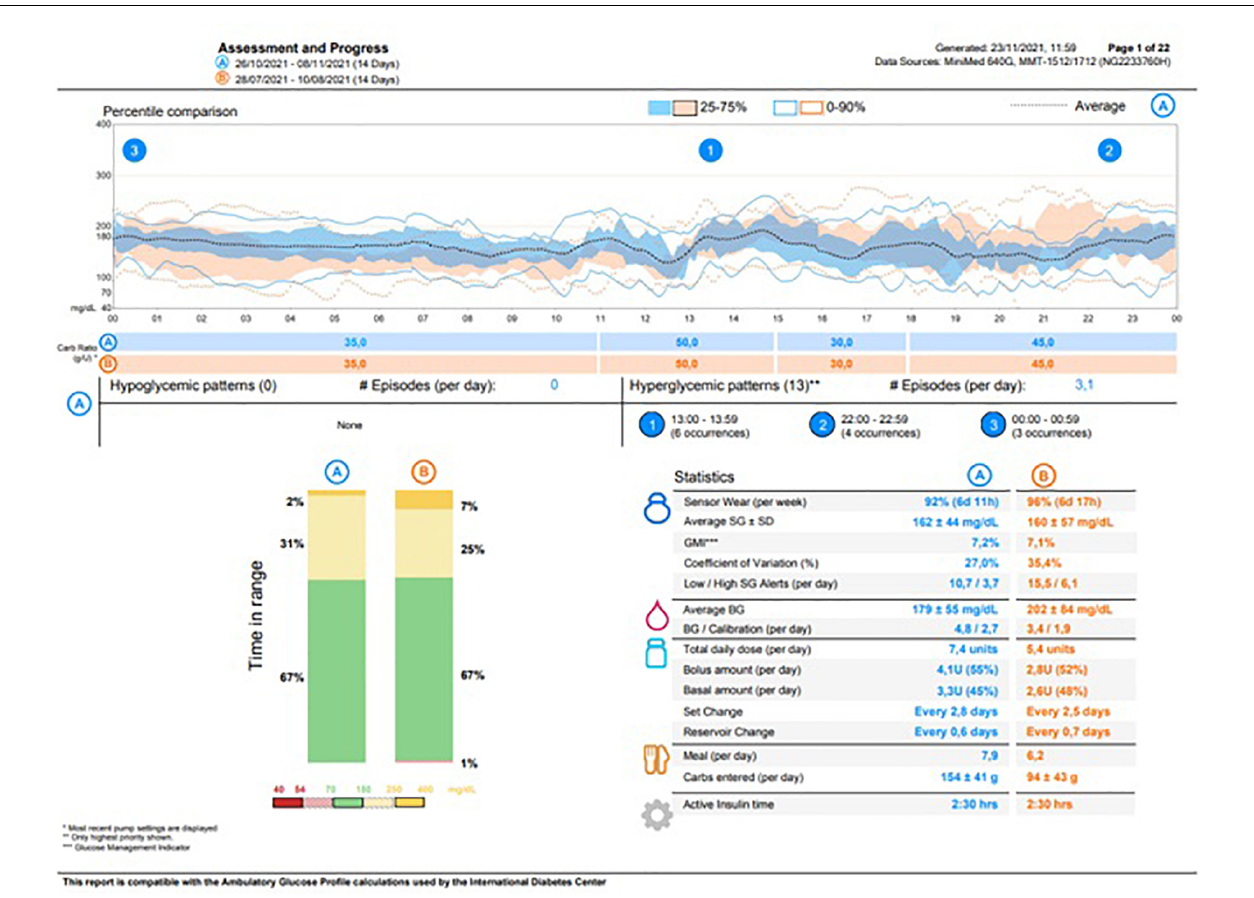
FIGURE 2 | Ambulatory glucose profile at patient’s most recent metabolic